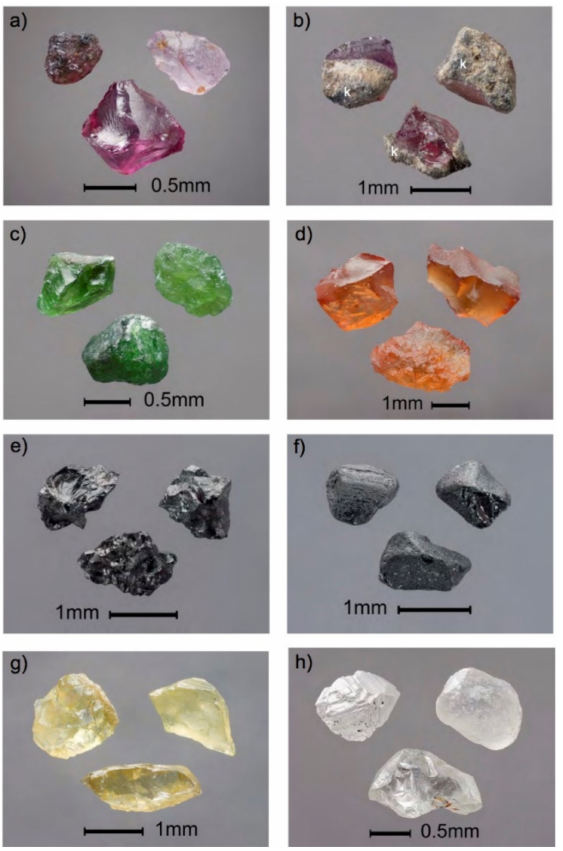
Figure 1. Examples of the colour and habit variations in kimberlite indicator minerals that can be observed using optical techniques (modified from McClenaghan and Paulen, 2020): ( a ) purple to pink Cr-pyrope; ( b ) Cr-pyrope with dark green-grey kelyphite rims (k); ( c ) Cr-diopside; ( d ) eclogitic garnet; ( e ) Mg-ilmenite; ( f ) chromite showing resorbed crystal faces; ( g ) forsteritic olivine; ( h ) diamond. Mineral photography by Michael J. Bainbridge. Eclogitic garnet grains provided by Mineral Services; diamond provided by Herb Helmstaedt, Queen’s University. Modified from McClenaghan and Paulen (2018)